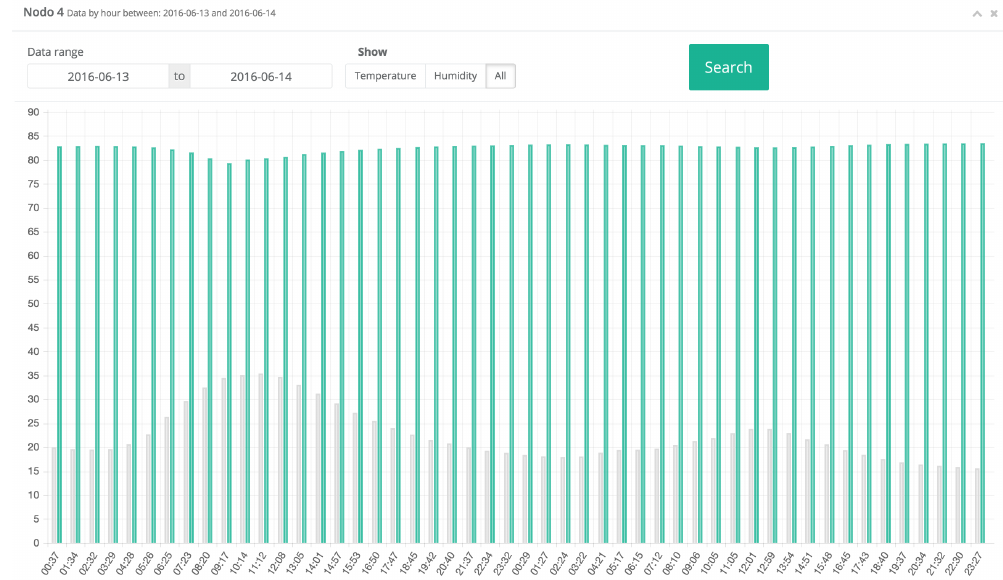
Figure 14. Data collected on node 4 on 13–14 June